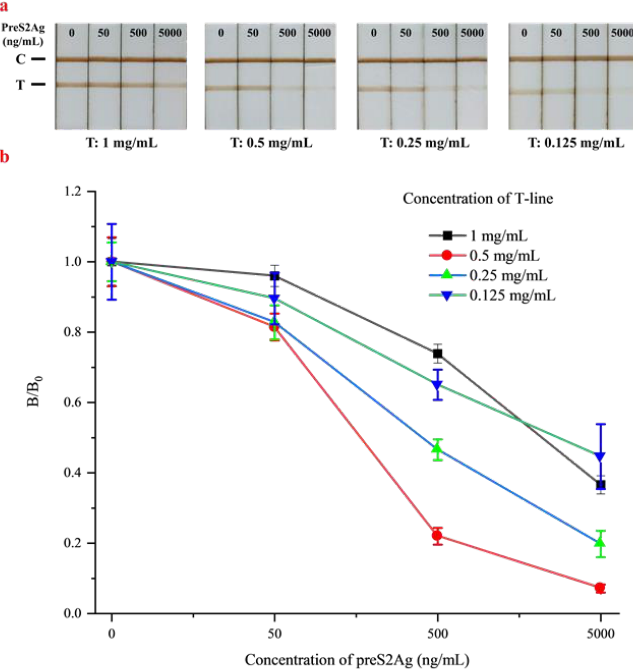
Figure 3. Optimization of different T-line concentrations with 0, 50, 500, and 5000 ng/mL of preS2Ag. ( a ) Qualitative results. ( b ) Quantitative results. The error bars represented the standard deviation of three repeats (n = 3).